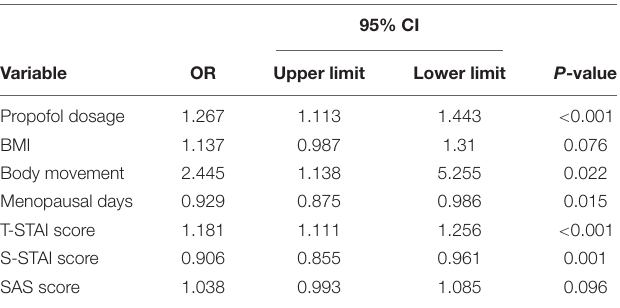
TABLE 2 | Logistic regression analysis.